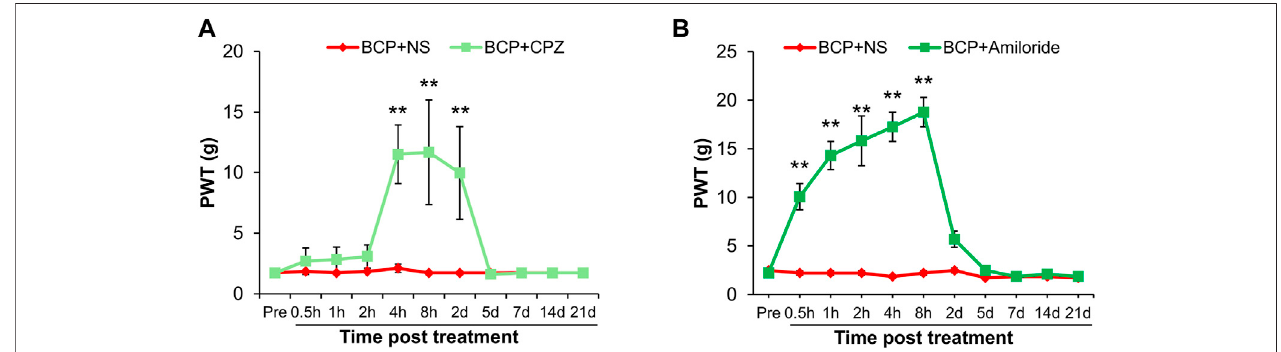
FIGURE 4 | The PWT of BCP rats was increased after Capsazepine (CPZ) or Amiloride injection. (A) The PWT of BCP rats (2 weeks after transplantation) subcutaneous injected with TRPV1 inhibitor (CPZ, 15 mg/kg) were signi fi cantly increased than in age-matched BCP rats injected with same volume of NS from 4 h to 2 days (** p < 0.01 vs. BCP + NS, two-way repeated measures ANOVA followed by Sidak ’ s post hoc test). (B) The PWT of BCP rats (2 weeks after transplantation) intrathecal injected with ASIC3 inhibitor (Amiloride, 0.1 mg/10 μ L) were signi fi cantly increased than in age-matched BCP rats injected with the same volume of NS from 0.5 to 8 h (** p < 0.01 vs. BCP + NS, two-way repeated measures ANOVA followed by Sidak ’ s post hoc test).